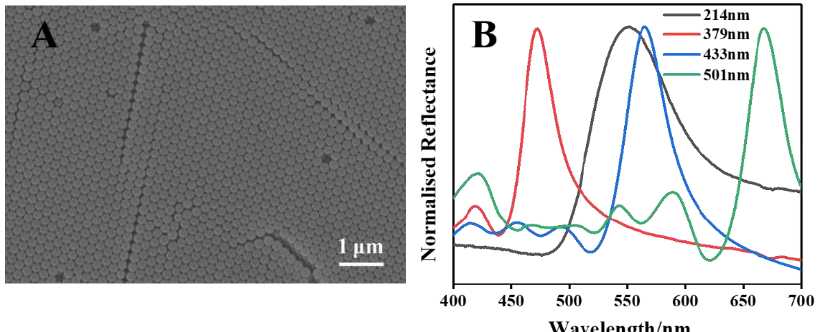
Figure 1. ( A ) SEM image of the top surface of the opal template (PS: 214 nm). ( B ) Normalized reflectance spectra collected along the (111) plane of the opal structured templates with microspheres of different diameters.